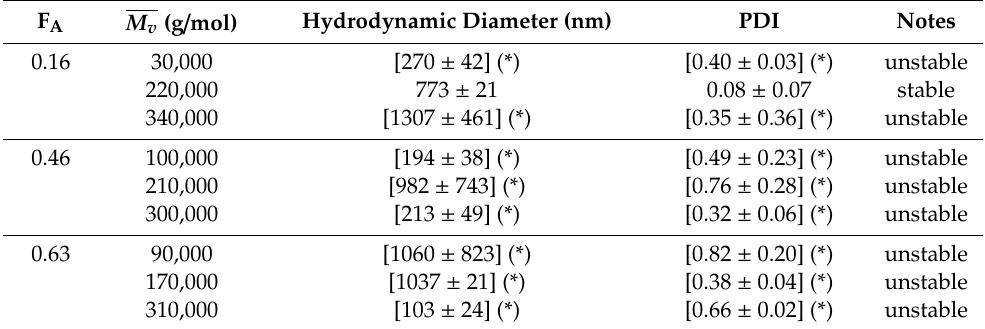
Table 3. Characterization of CH/HA coacervates after dilution 1:10 ( v / v ) in Phosphate Buffered Saline (PBS) buffer. Coacervates were fabricated using chitosans at different fractions of acetylated units (F A ). The hydrodynamic diameter, stability at time zero and polydispersity index (PDI) (all of them ± SD) of the resulting formulations are reported.